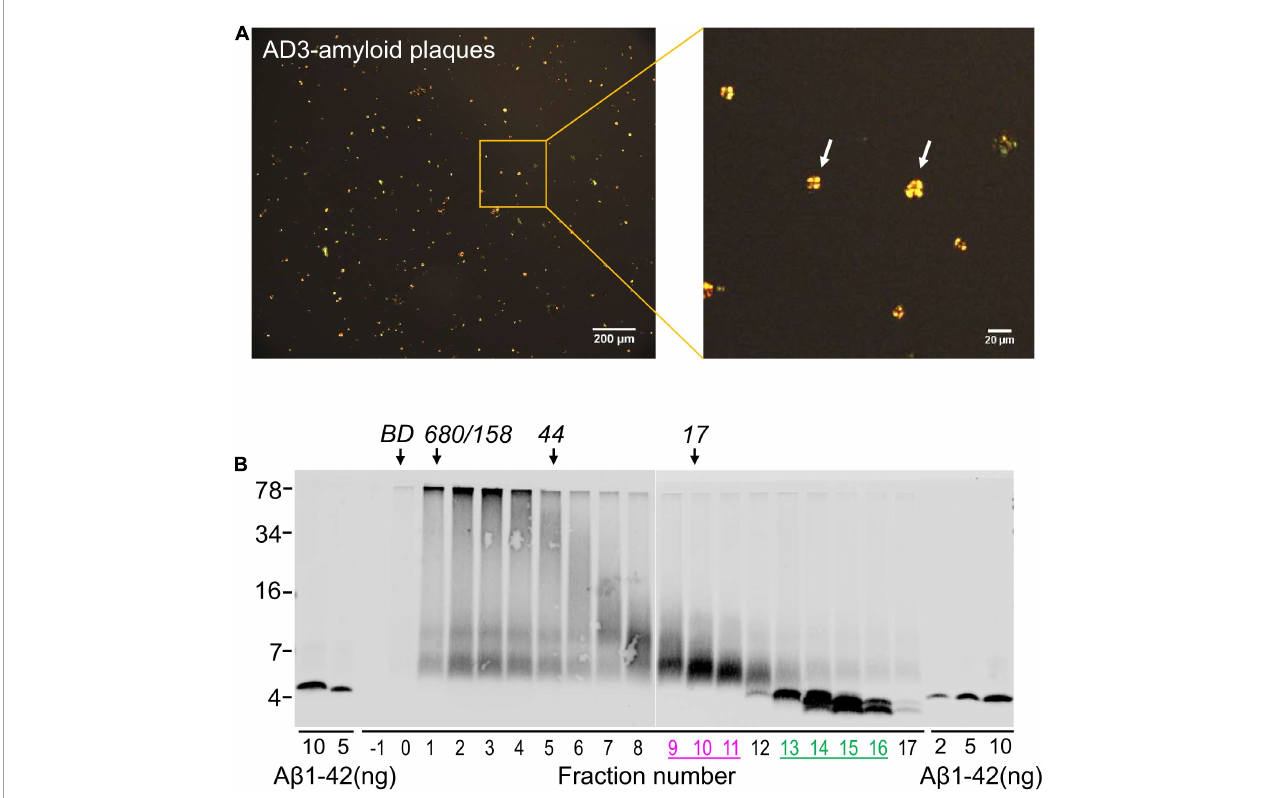
FIGURE5 Solubilized amyloid plaques contain A β dimers and monomers. (A) Amyloid plaques were isolated from AD brain and characterized by Congo red staining. (B) Congo red-positive amyloid plaques were dissolved in formic acid, chromatographed on SEC and used for western blot with 4G8. The elution of Blue dextran (BD) and globular protein standards is indicated by downward arrows and SDS-PAGE molecular weight standards are on the left. Synthetic A β 1–42 was used as control for Western blotting